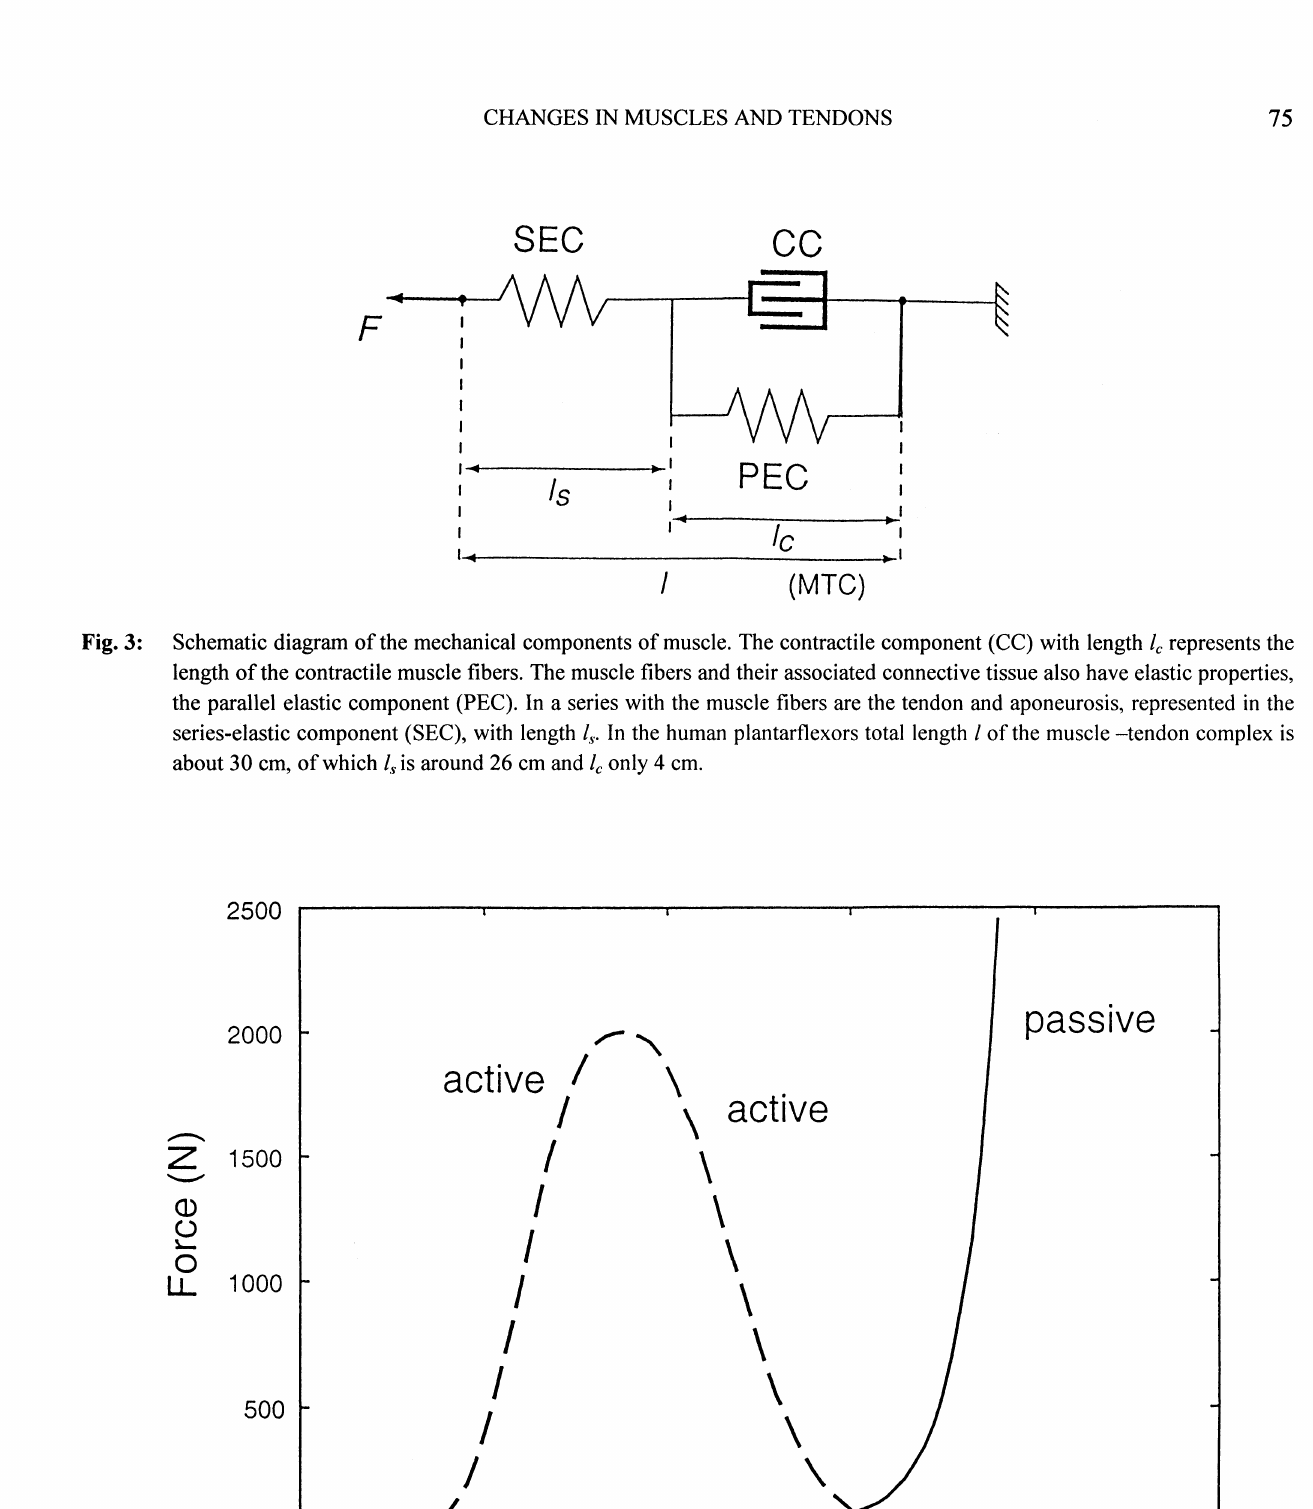
Force-length relations of CC (active force, dashed) and PEC (passive force, solid) for the human plantarflexors as a Fig. 4: function of CC length lc. The active force is controlled in amplitude by the muscle activation, peak level can be between 0 and about 5000 N. The curves have been obtained from the same subject as from the walking recording of Fig.